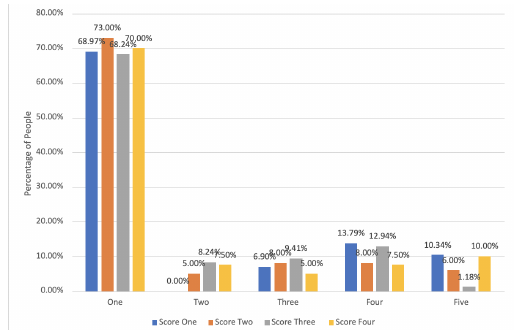
Figure 10. HAIS-Q score and password